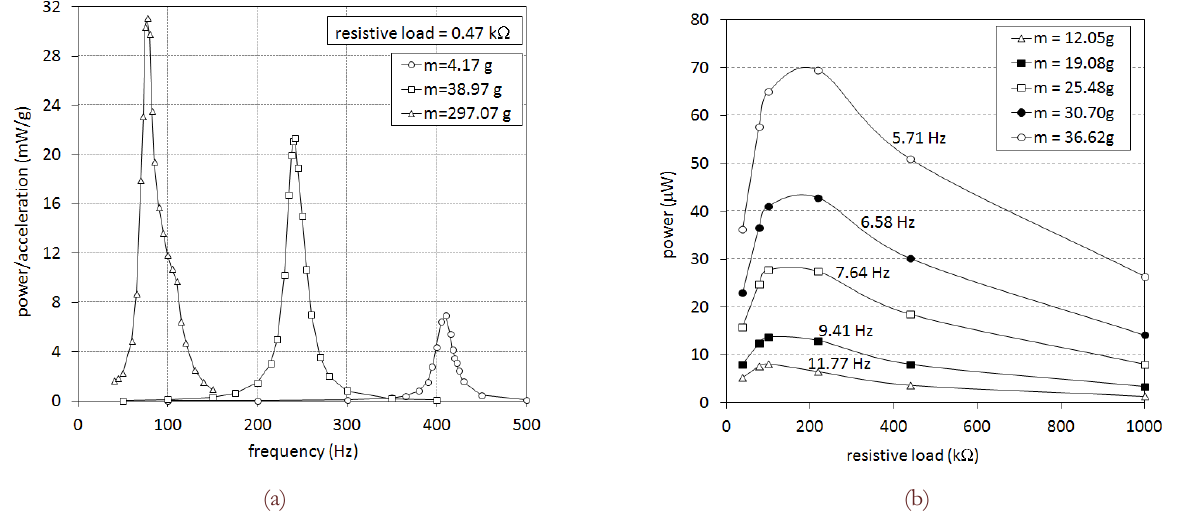
Figure 8: Output power generated by commercial harvester as function of the excitation frequency (a) and by laboratory prototype as function of the resistive load in resonance conditions (27 Hz) for variable seismic mass